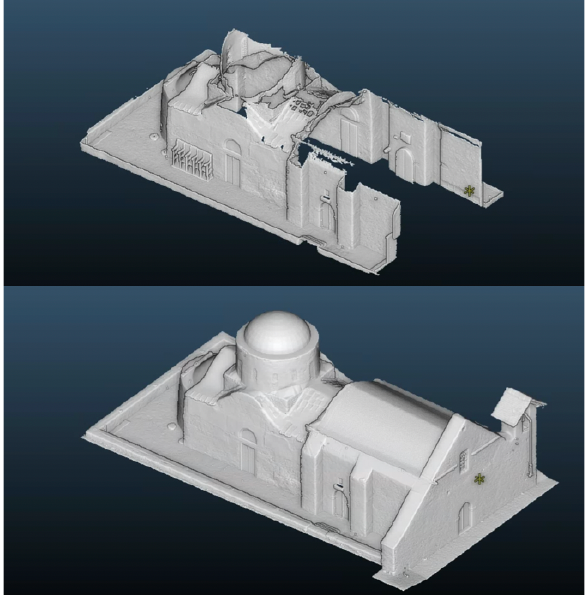
Figure 6. Panagia tou Araka, Lagoudhera, ambulatory before (top) and after (bottom) the virtual